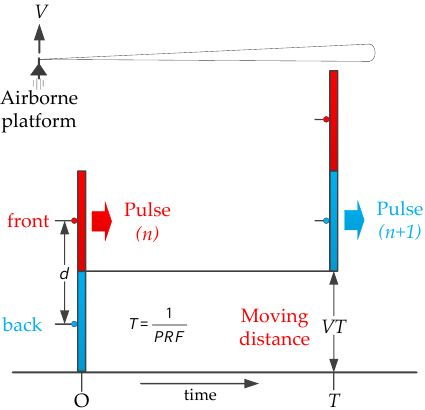
Figure 2. Schematic diagram of DPCA technology.